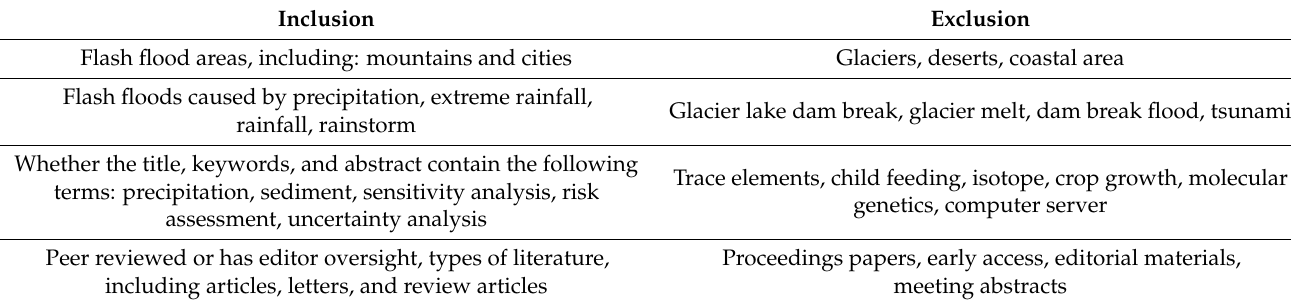
Table 1. Inclusion–exclusion Table 1. Inclusion – exclusion criteria.